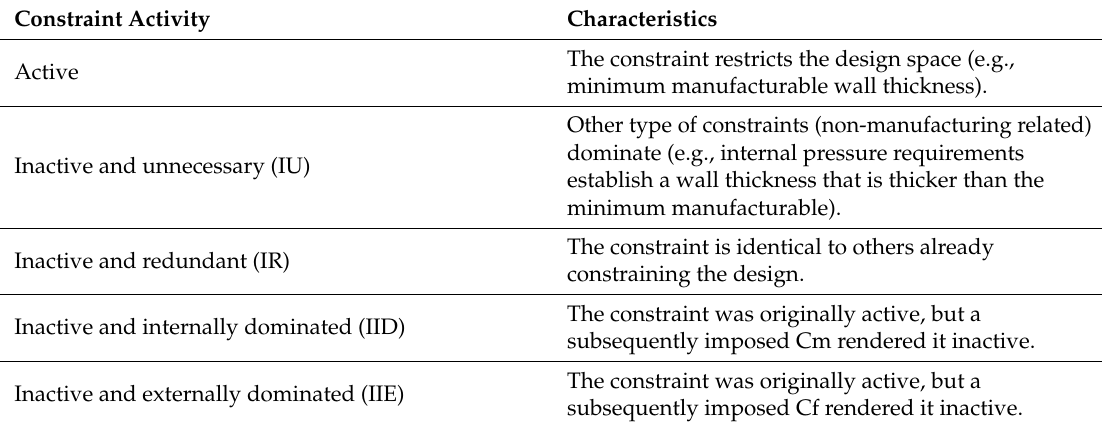
Table 1. Constraint activity as introduced by Patterson and Allison